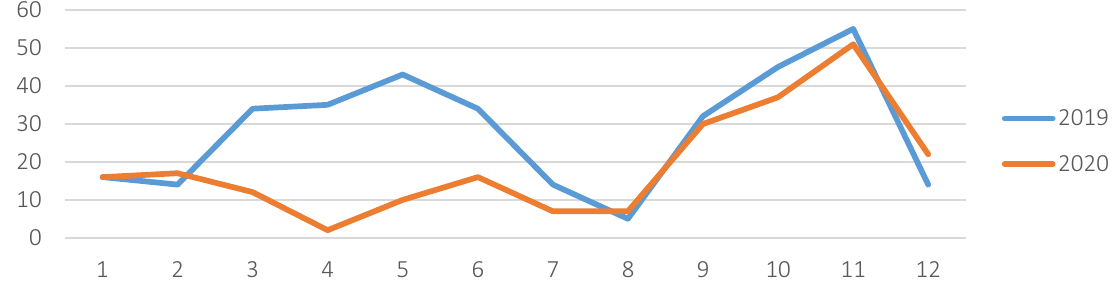
Figure 4. Distribution of the number of brokerage events by months in 2019 and 2020 according to the EEN event calendar